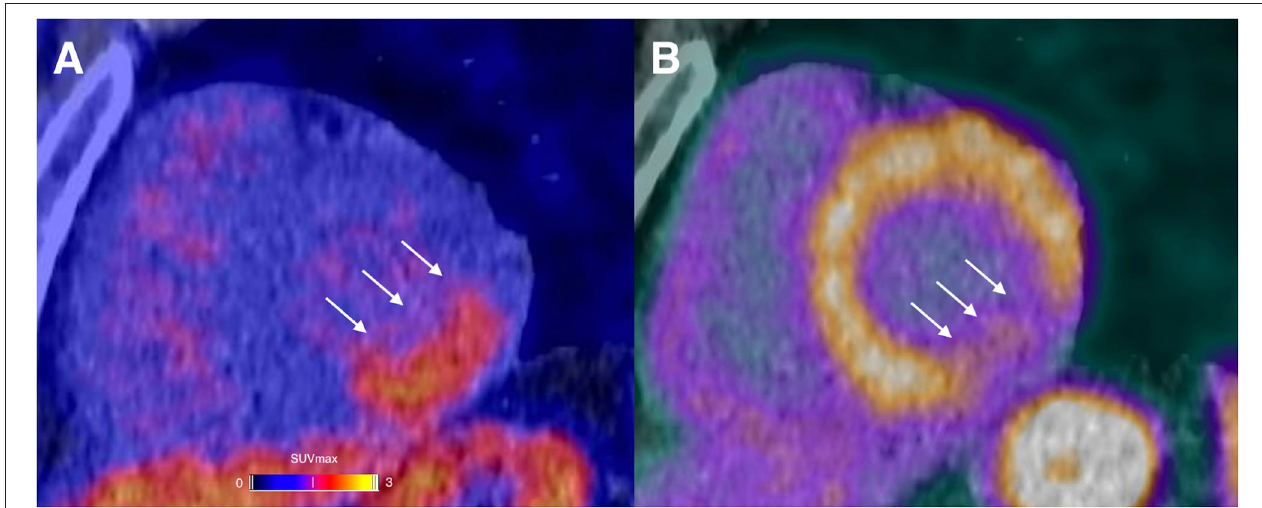
FIGURE 2 | A 44-year-old male presented with chest pain in the emergency room. The initial ECG displayed sinus-rhythm with ST elevation in inferior derivations. The laboratory results showed severely elevated cardiac troponin (up to 7,220 ng/l). Percutaneous coronary intervention with stenting of the completely occluded proximal left circumflex artery was performed without complications. A α v β 3 -targeting PET agent ( 68 Ga-Nodaga-RGD) was used to assess integrin expression 9 days after the event. Focal tracer retention was localized in the basal and mid inferolateral segments (arrows; A ). PET/CT examination using Rubidium-82 revealed a severely reduced myocardial blood flow in the same basal and mid inferolateral segments (arrows; B